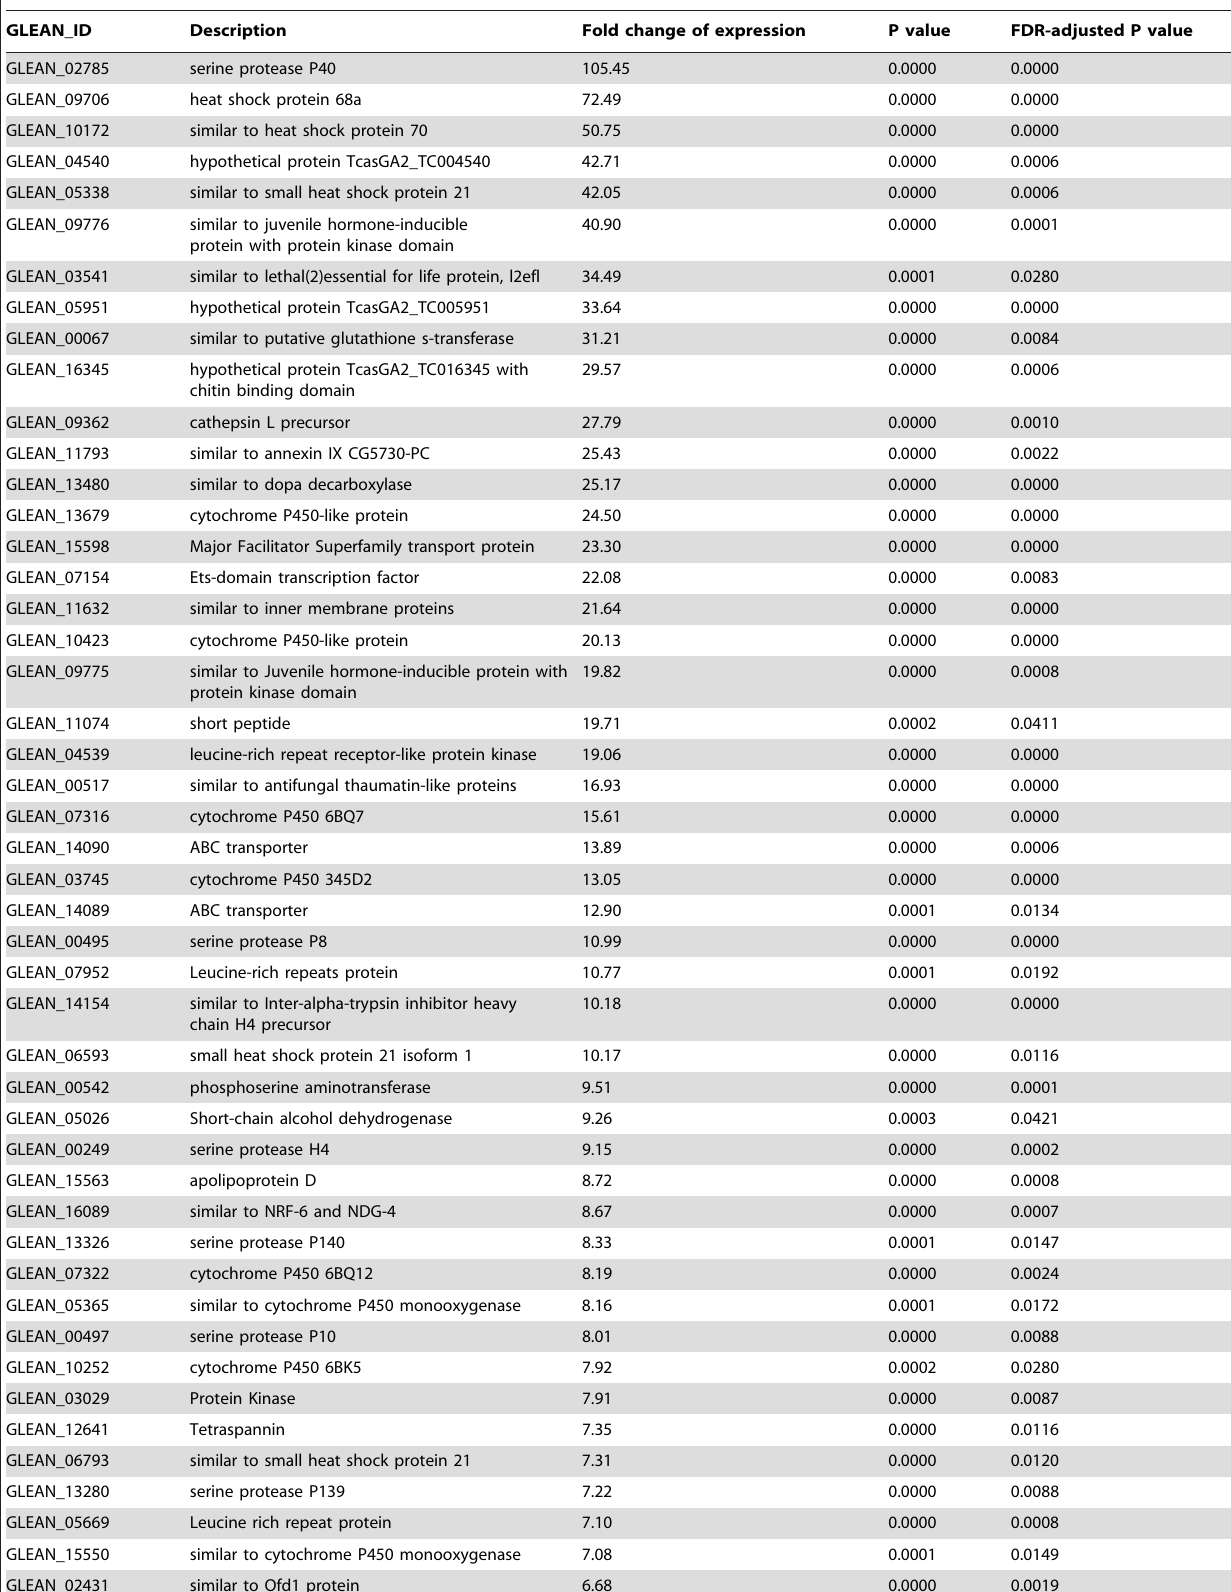
Table 3. Transcripts with significant differential expression upon LPS-challenge in adult